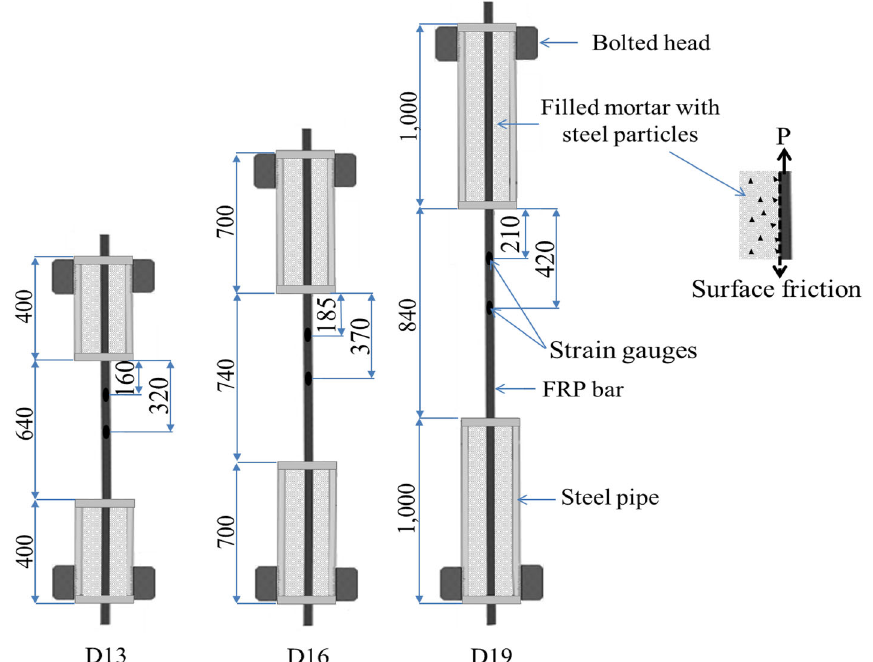
Fig. 3 Details of test specimens (unit in